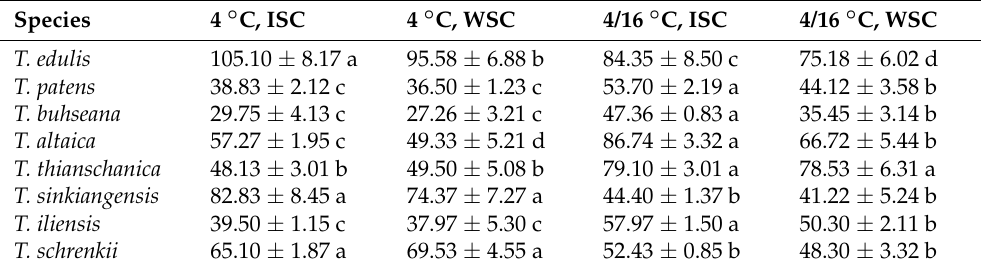
Table 5. Effects of seed coat on the T 50 of the eight wild Tulipa species native to China. Species 4 ◦ C, ISC 4 ◦ C, WSC 4/16 ◦ C, ISC 4/16 ◦ C, WSC T. edulis